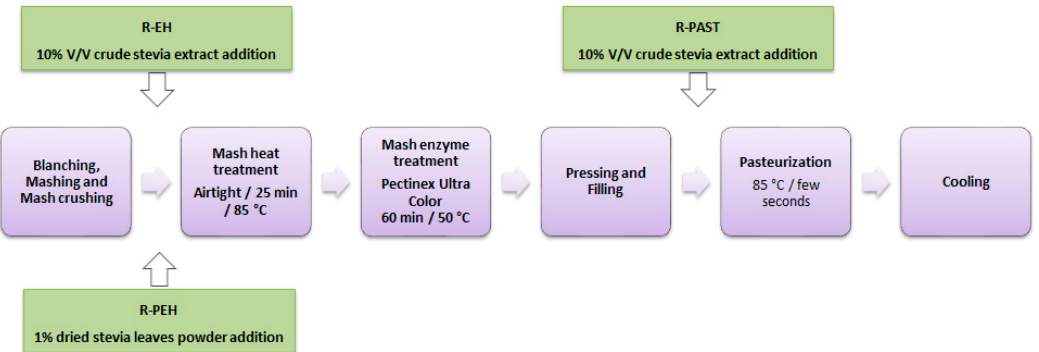
Figure 1. Flow diagram to produce raspberry juice. Green colored boxes indicate the various stevia addition points leading to different sweetened juices (namely R-EH (supplemented with 10% v / v of stevia crude water extract immediately before heat treatment), R-PEH (supplemented with 1% w / v of stevia dried leaf powder immediately before heat treatment), and R-PAST (supplemented with 10% v / v of stevia crude water extract immediately before pasteurization)).